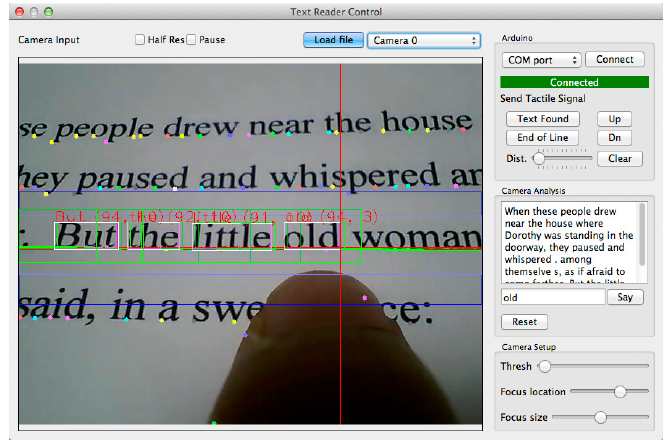
Figure 27. The process of the extraction and detection of printed text line [47].